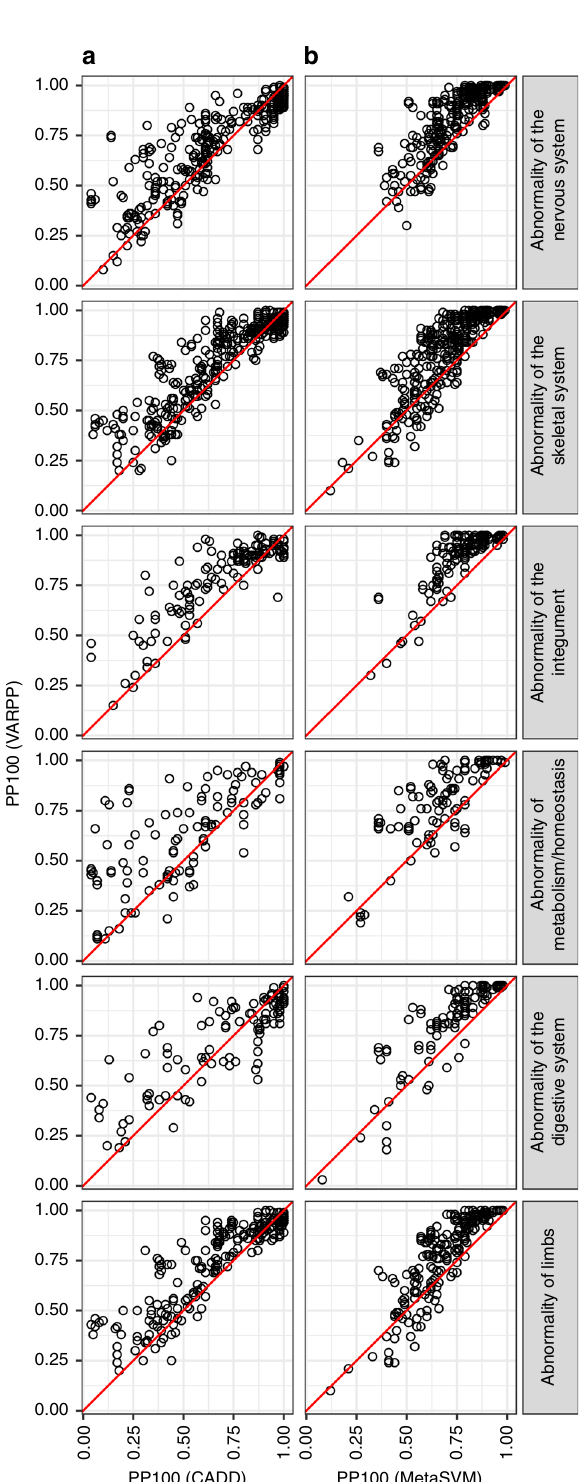
Fig. 3 Performance of VARPP classi fi ers by disease group. a Agreement scatter plots comparing the PP100 for VARPP including CADD + GTEx speci fi city ( y axis) versus the PP100 for CADD scores alone ( x axis). b Agreement scatter plots comparing the PP100 for VARPP including MetaSVM + GTEx speci fi city ( y axis) versus the PP100 for MetaSVM scores alone ( x axis). The red line is the line of